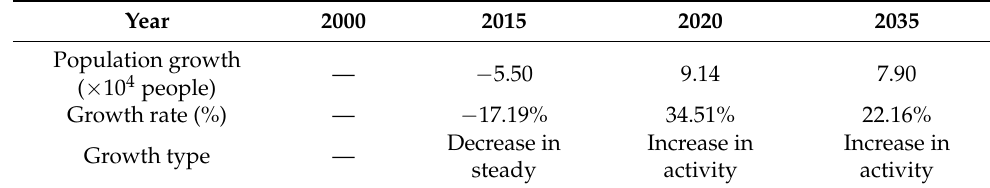
Table 8. Rural population change in Deqing during 2000–2035.